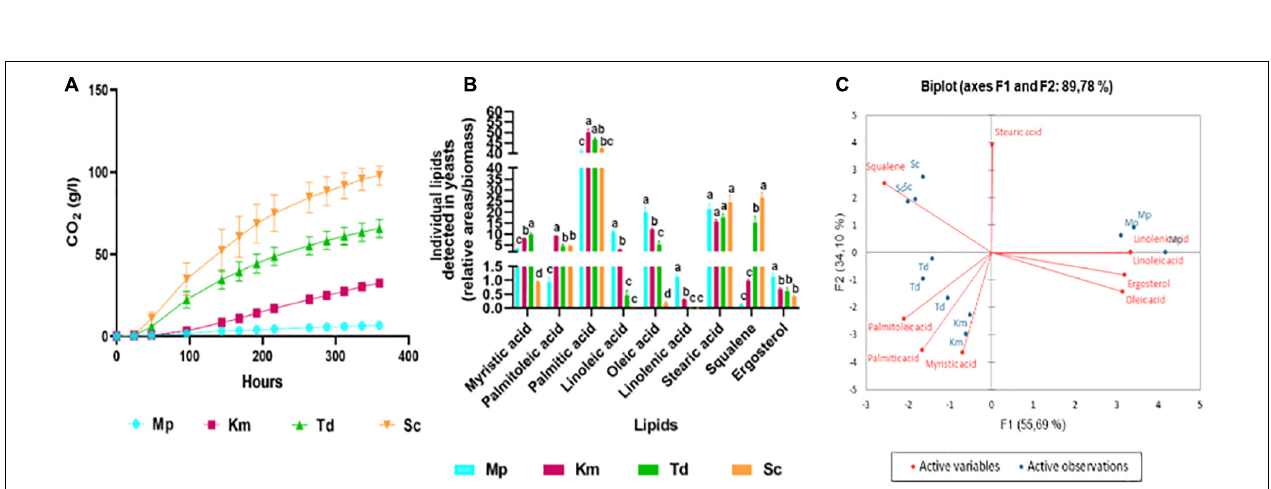
FIGURE 5 | The carbon dioxide production (A) , cellular lipid profile (B) and principal component analysis biplot (C) of M. pulcherrima, K. marxianus , T. delbrueckii and S. cerevisiae at the end of alcoholic fermentation in synthetic grape juice-like media with no lipids. Blue bars- M. pulcherrima , pink bars— K. marxianus , green bars— T. delbrueckii and orange bars— S. cerevisiae . Results obtained for treatments with the same letters are not statistically significant ( p < 0.05).